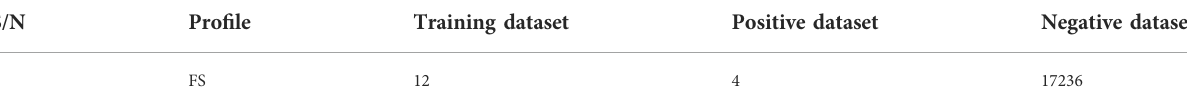
TABLE 2 Pro fi le creation